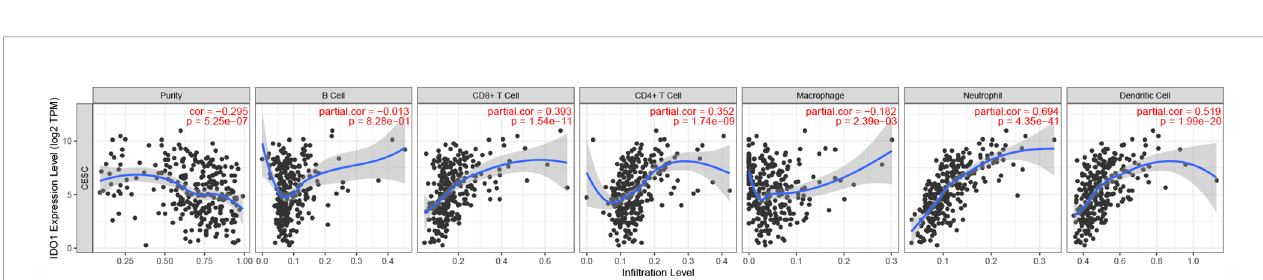
FIGURE 2 | Expression level of IDO1. [ (A) IDO1 expression level in cancerous and paraneoplastic tissues of CESC from TCGA datasets; (B) IDO1 expression level in cancerous and normal tissues of CESC from TCGA+GTEx datasets; (C) IDO1 expression level in different N stages of CESC; (D) IDO1 expression level in CESC with or without HPV type 16 infection; ns: P > 0.05, *P < 0.05, ***P < 0.001].